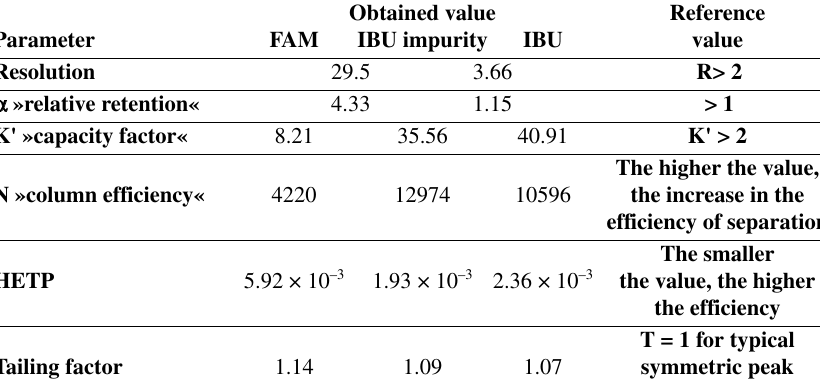
Table 5: Parameters required for system suitability testing of HPLC